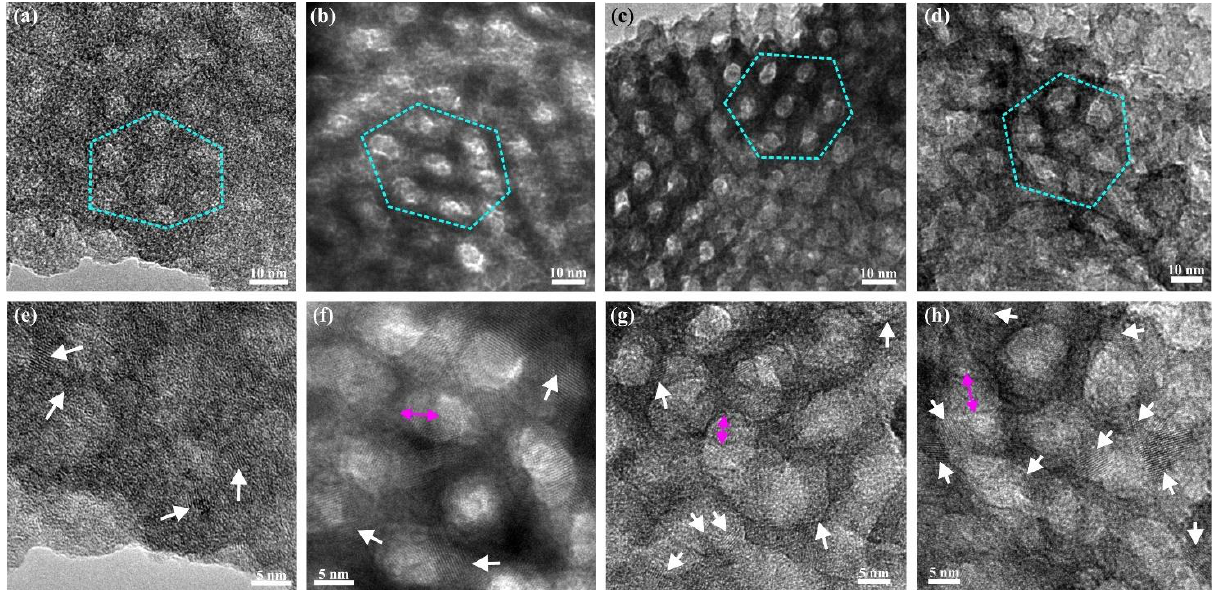
Figure 3. BF TEM images of mesostructured titania with synthesis time 3 h, before template removal ( a ), and after template removal with synthesis times of 3 h ( b ), 6 h ( c ), and 24 h ( d ). The hexagonal order of the pores has been outlined with cyan dotted lines. ( e – h ) HRTEM images of samples ( a – d ), respectively, in which some of the anatase crystalline areas are highlighted with white arrows. Magenta double arrows denote the shadowing of pores due to the inclined viewing direction.